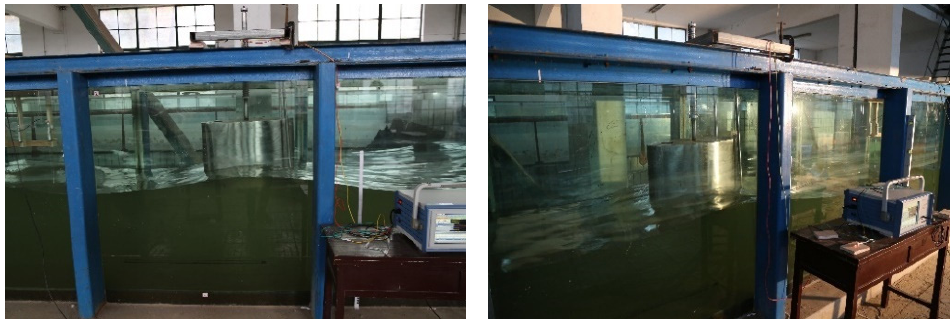
Figure 5. Installation of WEC experimental device in flume.